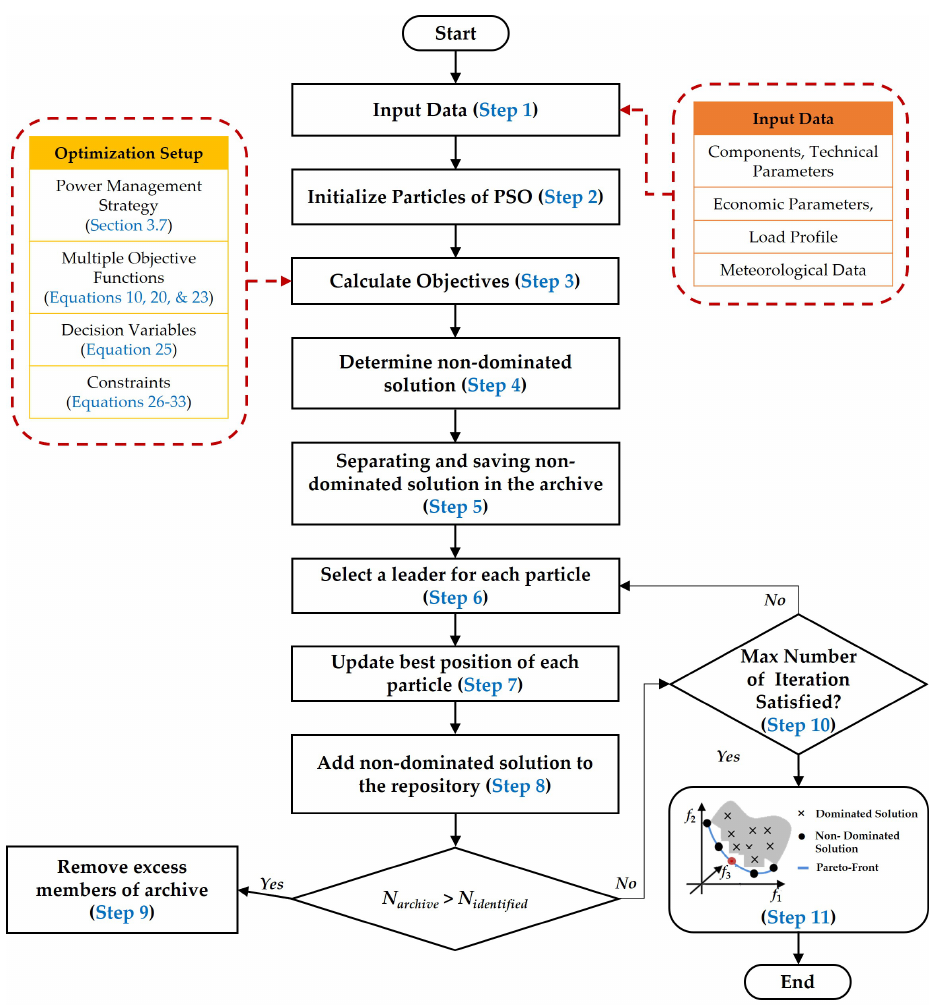
Figure 12. Flowchart of the multi-objective particle swarm optimization of